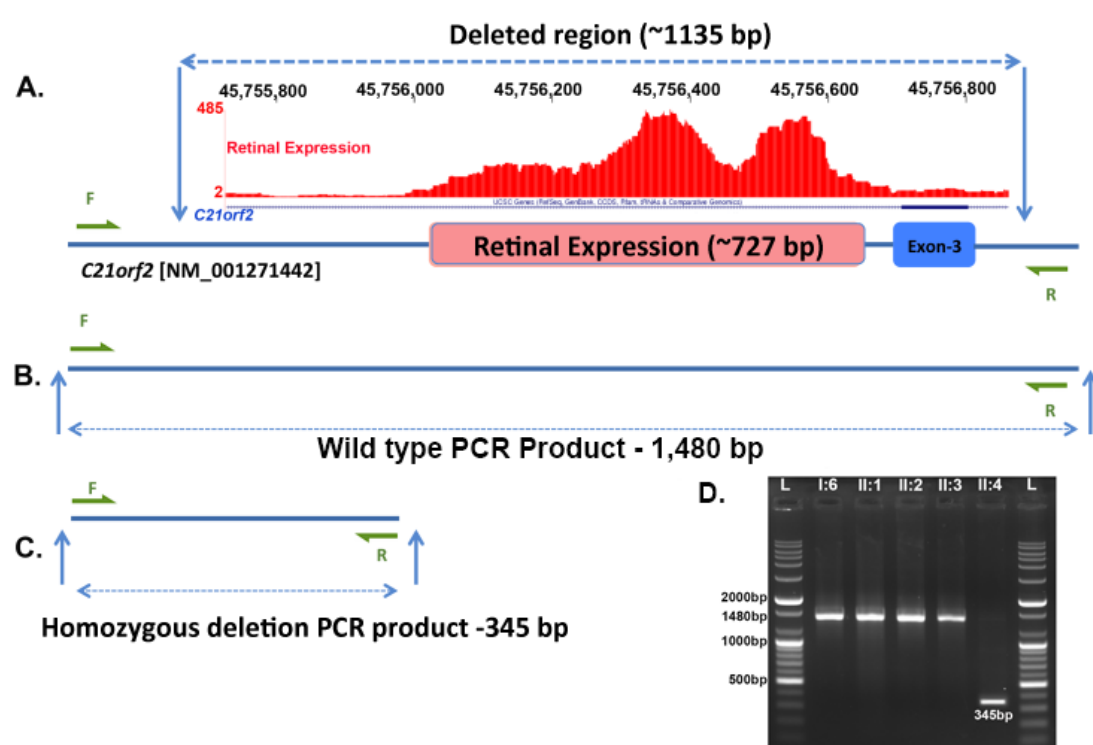
Figure 5. Segregation analysis of the deletion in C21orf2 . ( A ) Region of C21orf2 encompassing the 1135 base pair (bp) homozygous deletion (Chr21: 45,755,728–45,756,862) observed in patient II:4 of the pedigree RF.L.11.10. A 727 bp region (Chr21: 45,755,983–45,756,710) within the 1135 bp homozygous deletion is reported to encompass retina expressed sequence [17]. The retinal transcriptome ribonucleic acid-sequence (RNA-seq) coverage data is shown in red. In addition, this deletion also encompasses exon 3 of NM_001271442 transcript of C21orf2 ; ( B , C ) Region of C21orf2 amplified by PCR to detect the presence of wild type or mutant alleles; ( D ) Gel electrophoresis of the PCR products of C21orf2 deleted region in members of RF.L.10.11 family. Presence of the 345 bp PCR product in II:4 indicated the presence of the homozygous deletion in C21orf2 whereas the other members had wild type alleles.